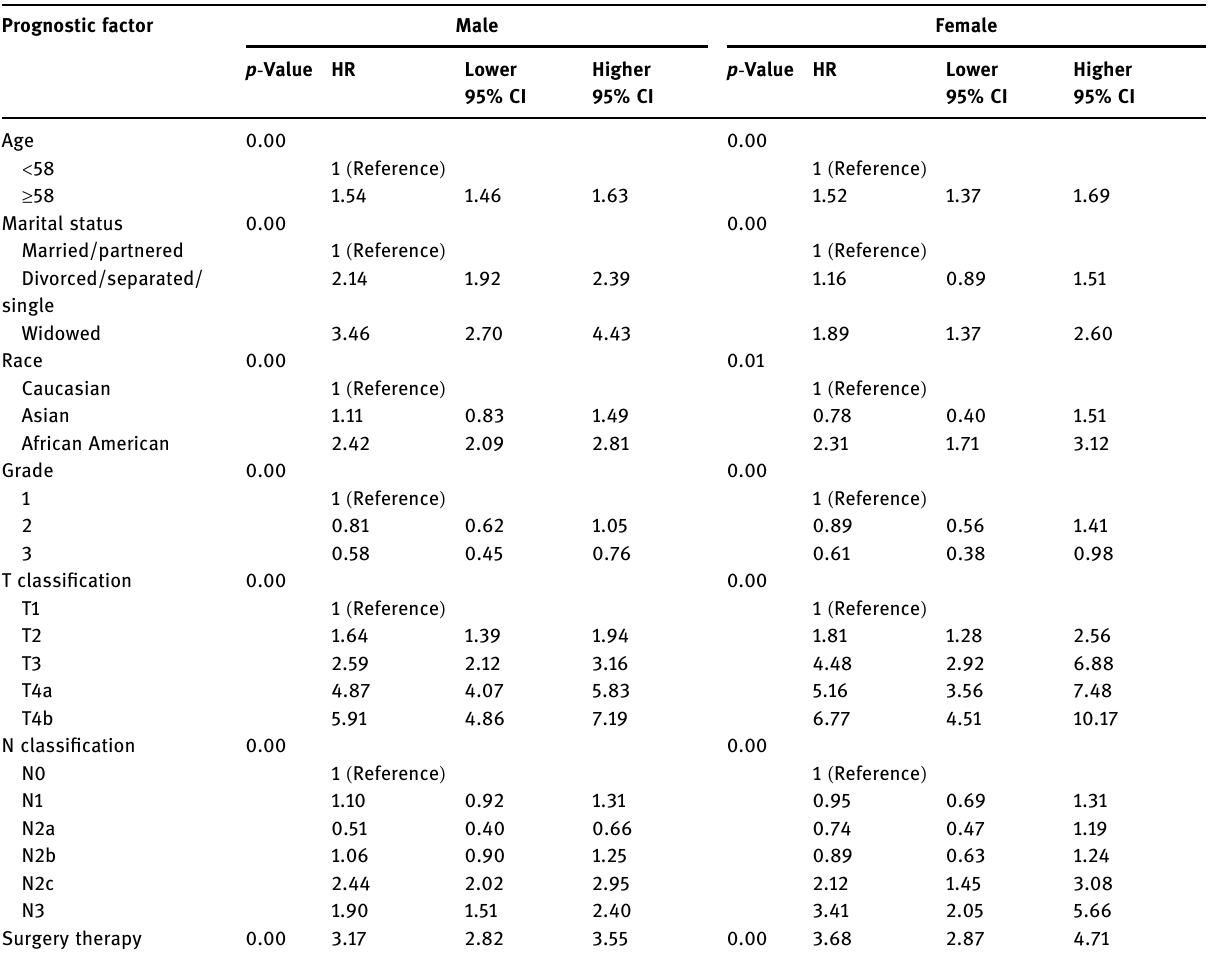
Table 2: Univariate analysis of CSS strati fi ed by gender Prognostic